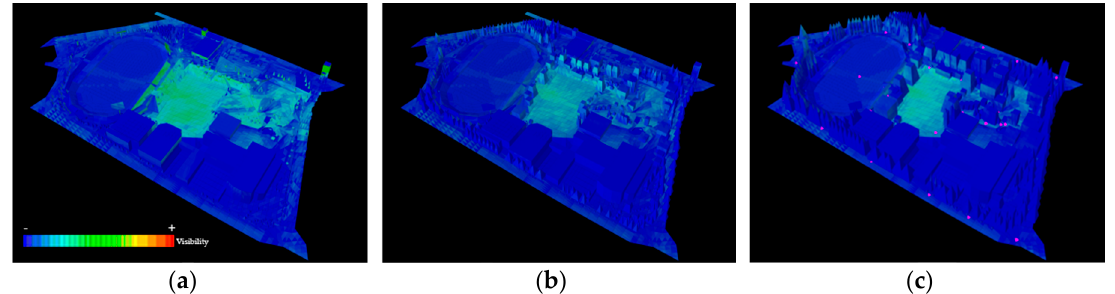
Figure 3. Visual connectivity maps of the effects of time in trees. ( a ) initial growth; ( b ) expected growth in 20 years; ( c ) full growth [17] (p. 222).